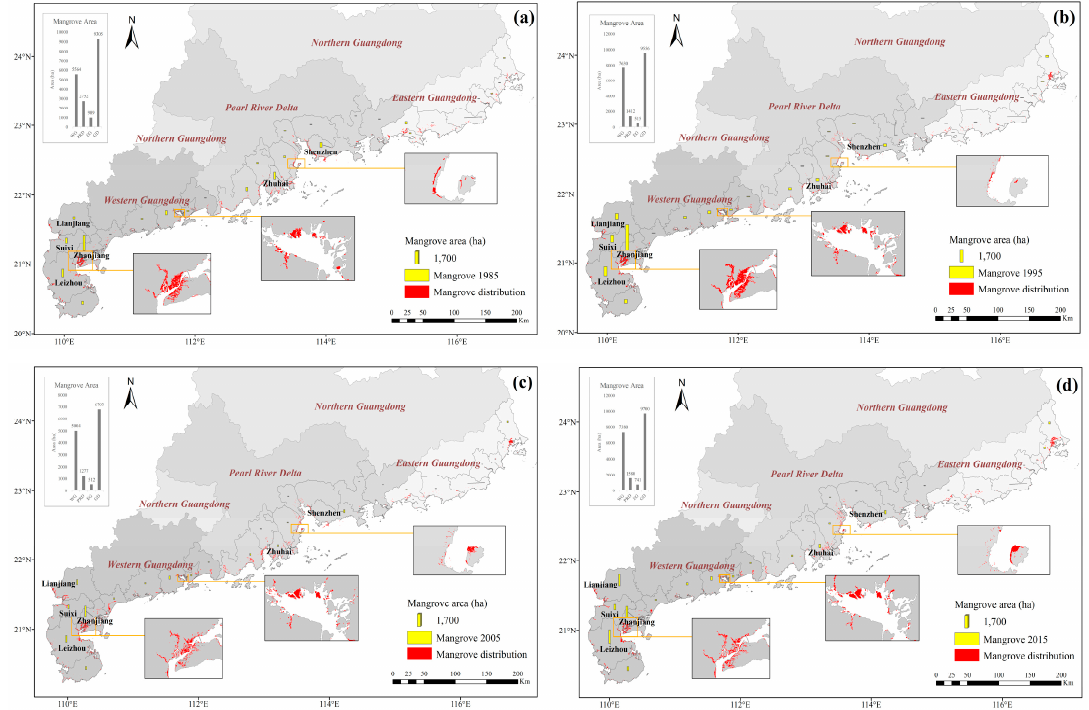
Figure 5. Spatial distribution of mangroves in coastal Guangdong during the period from 1985 to 2015: ( a ) spatial pattern of mangroves in 1985, ( b ) spatial pattern of mangroves in 1995, ( c ) spatial pattern of mangroves in 2005, and ( d ) spatial pattern of mangroves in 2015.